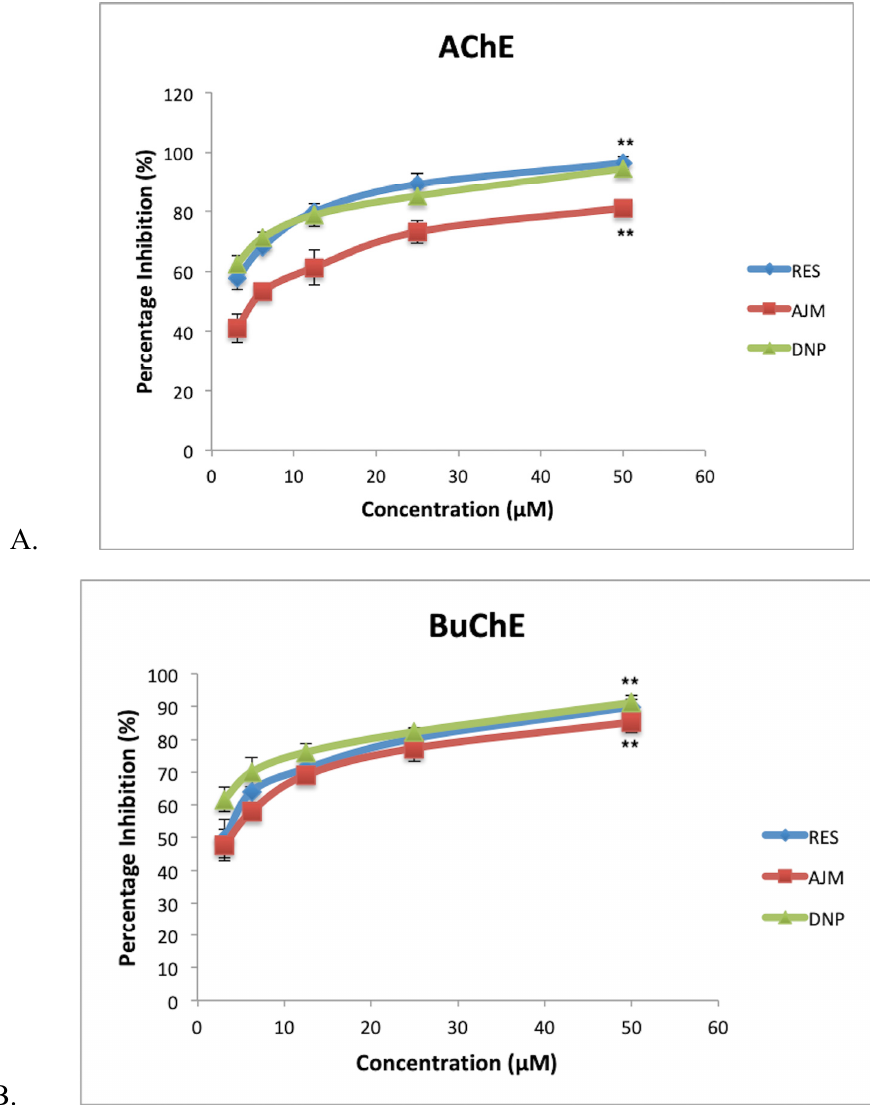
Figure 11. ( A ) acetylcholiesterase (AChE) percentage inhibition; ( B ) butyrylcholinesterase (BuChE) percentage inhibition at various tested concentrations of compounds (3.125–50 μ M); RES-reserpine, AJM—ajmalicine, DNP—donepezil; values represent mean ± SEM, n = 3; and difference in mean is statistically very significant (**) p < 0.001 as compared to control groups.